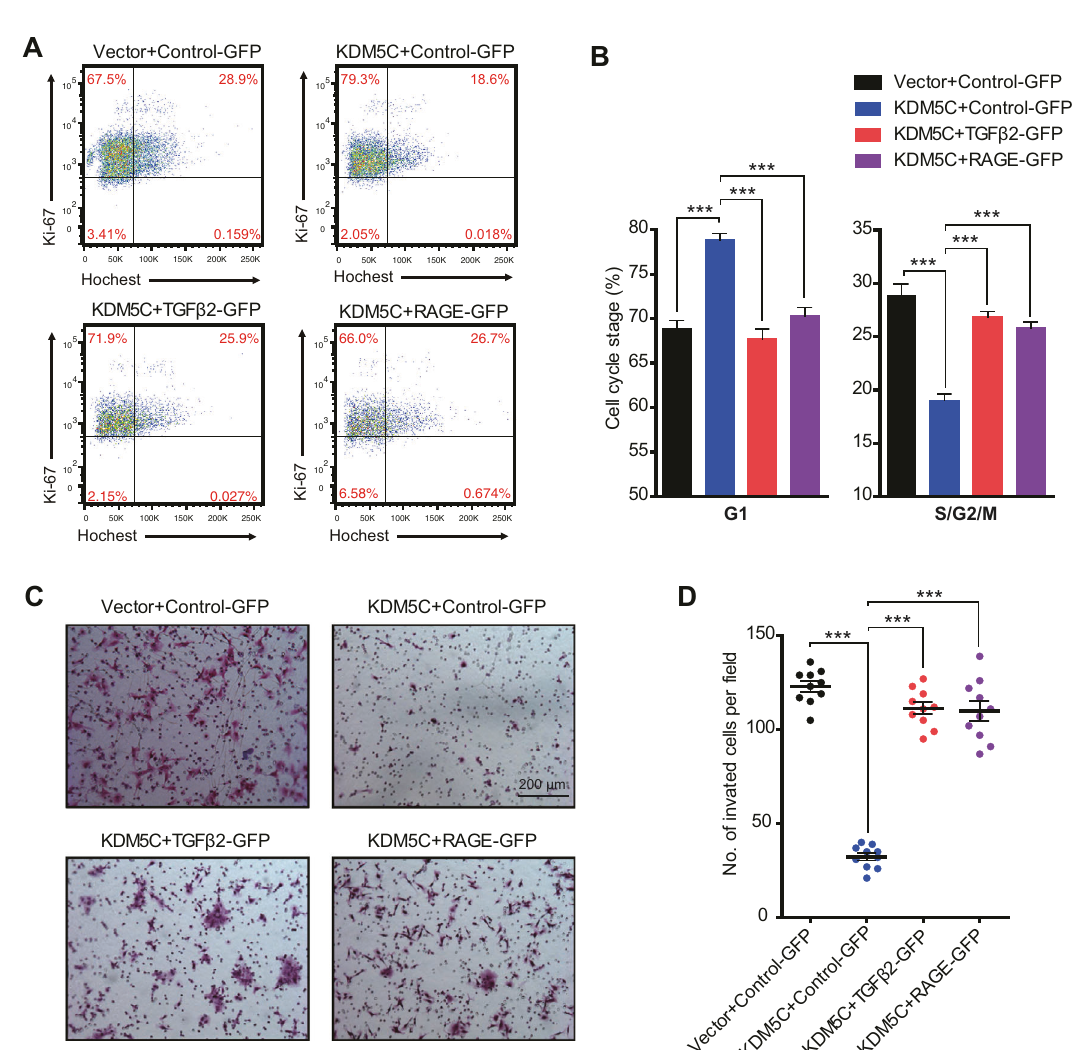
Fig. 6 TGF β 2 and RAGE represent two major targets of KDM5C to repress trophoblast proliferation and invasion. HTR-8 cells stably transfected with either control vector or KDM5C overexpression vector were additionally lentivirally transduced with control-GFP, TGF β 2-GFP, or RAGE-GFP, and the cell cycle status was then analyzed using fl ow cytometry ( A , B ), and the invasive ability of HTR-8 cells was determined using Image-Pro Plus 6.0 software ( C , D ); scale bar = 200 μ M; B, n = 3 for each group; D, n = 10 for each group. The ANOVA test was used to evaluate the statistical signi fi cance; *** p <